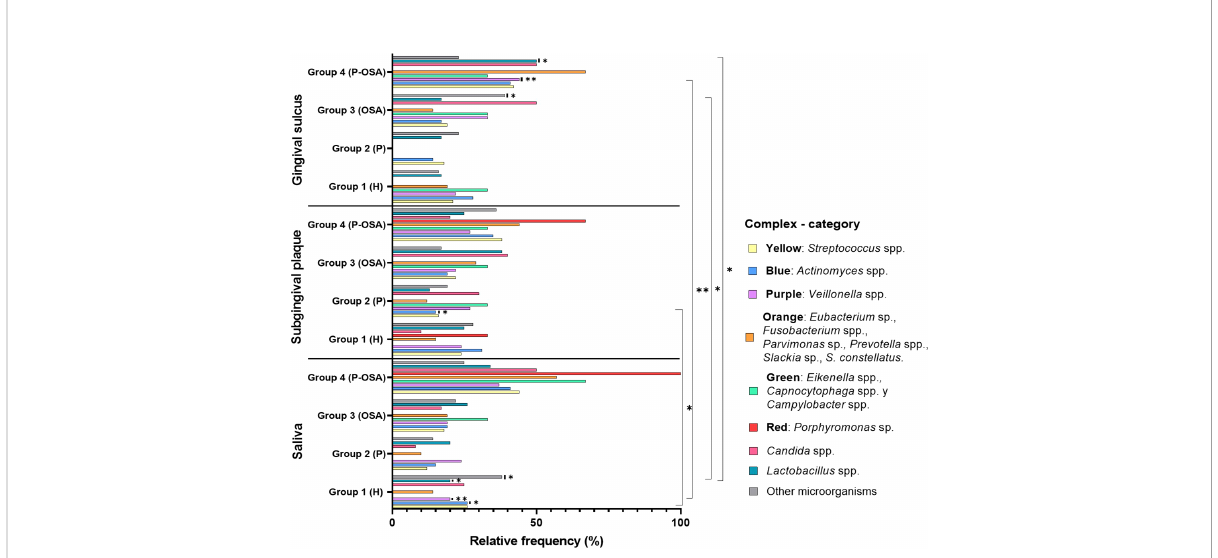
FIGURE 2 Relative frequencies of the complexes/categories in the oral samples by groups of patients. Signi fi cant differences between the relative frequencies of the complexes in each group were evaluated using the Kruskal-Wallis chi-square method; *p-value < 0.05, **p-value <